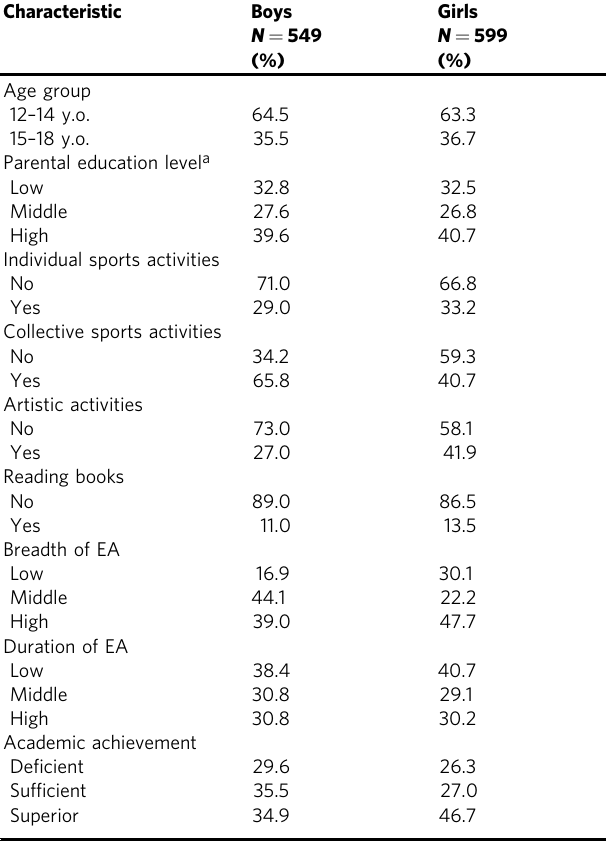
Table 1 Characteristics of the